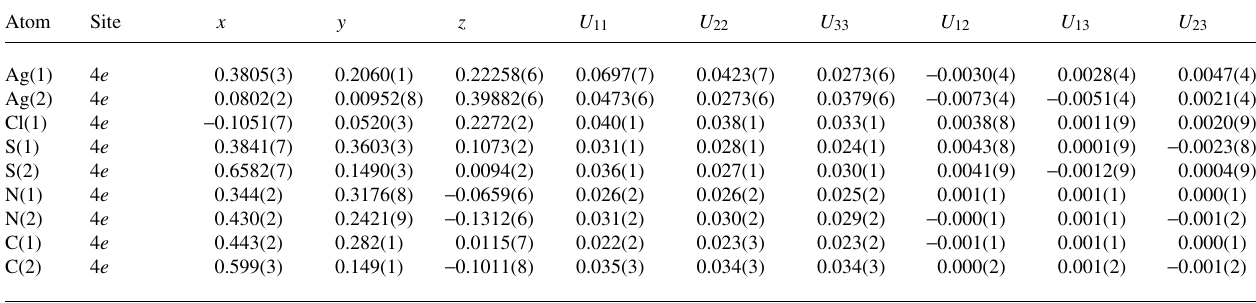
Table 3. Atomic coordinates and displacement parameters (in Å 2 )